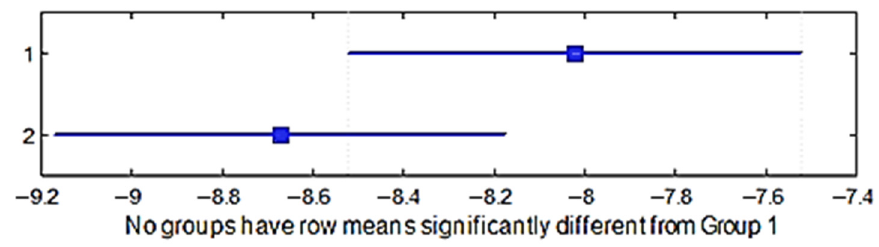
Figure 8. Confidence intervals of the shrinkage in the weft direction of different weave groups. A multiple comparison test was performed to determine whether the shrinkage in the weft direction differed between the two raw materials of the fabric. The p -value = 0.1578 > 0.05; thus, the averages of these groups were statistically the same. This means that the raw material had no influence on the shrinkage in the weft direction (Figure 9).